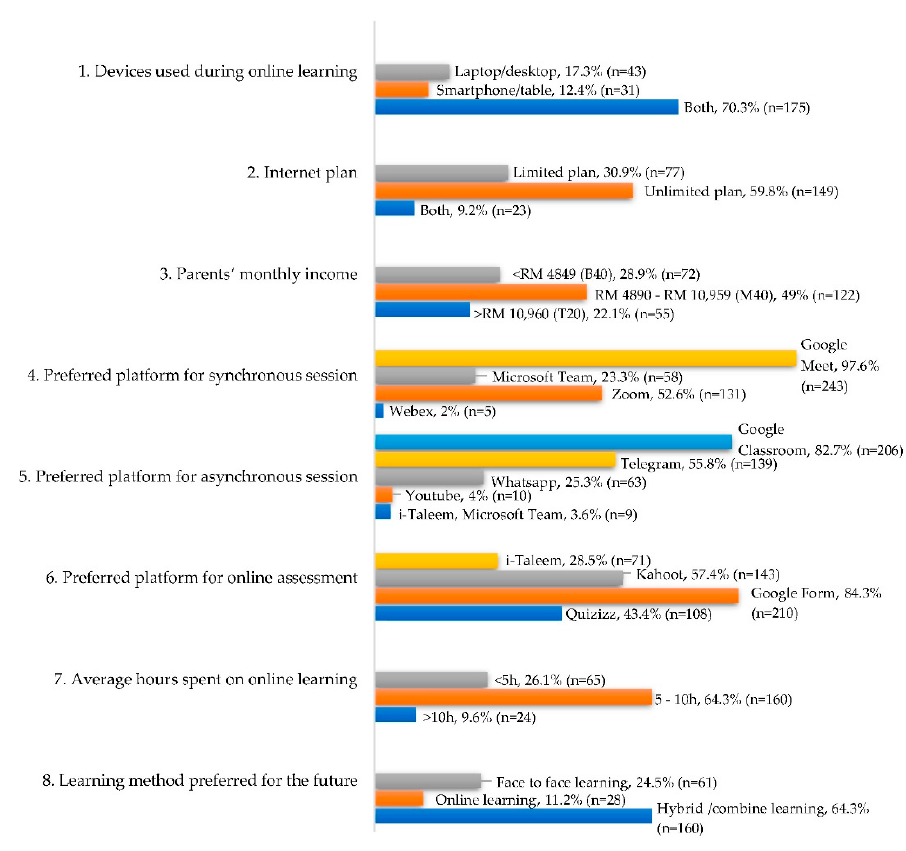
Figure 2. Online learning preferences.